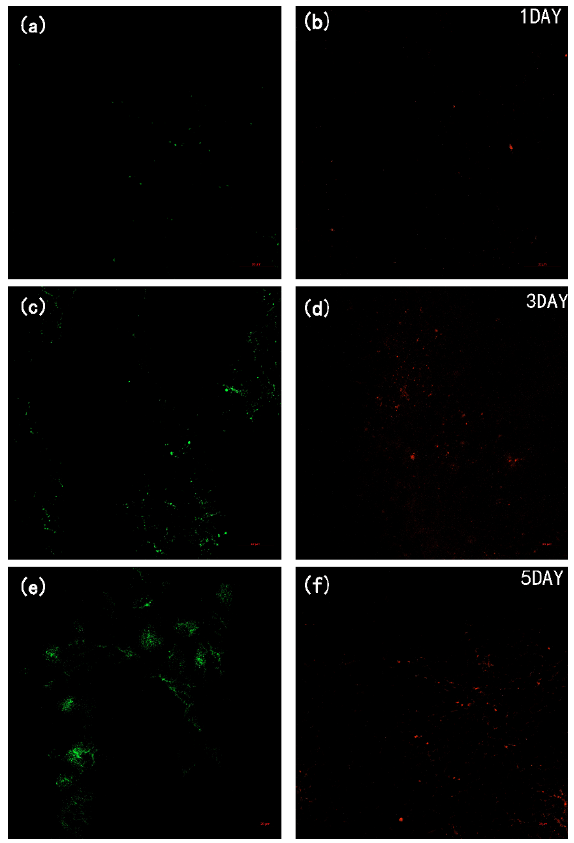
Figure 11. CLSM images of P-GO-DAA membrane during five days of bacterial culture cycle. ( a , c , e ) live bacteria on PVDF membrane; ( b , d , f ) dead bacteria on PVDF membrane.